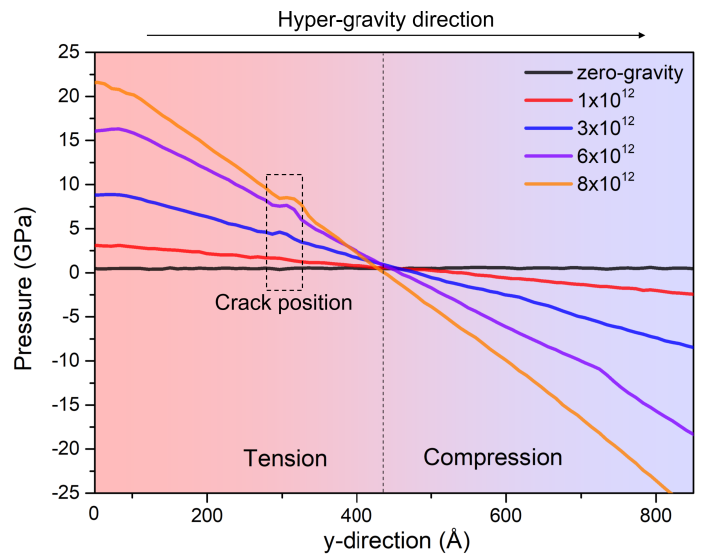
Figure 3. Hyper-gravity-induced gradient pressure at 300 K.